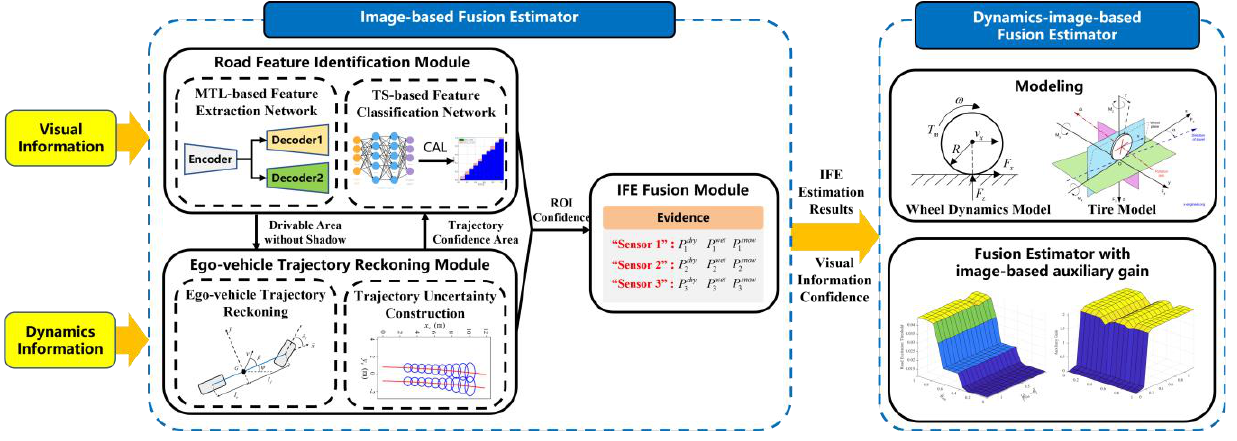
Figure 1. Overall framework of the proposed estimation method considering model uncertainty. (“CAL” denoted as “calibrated”.)